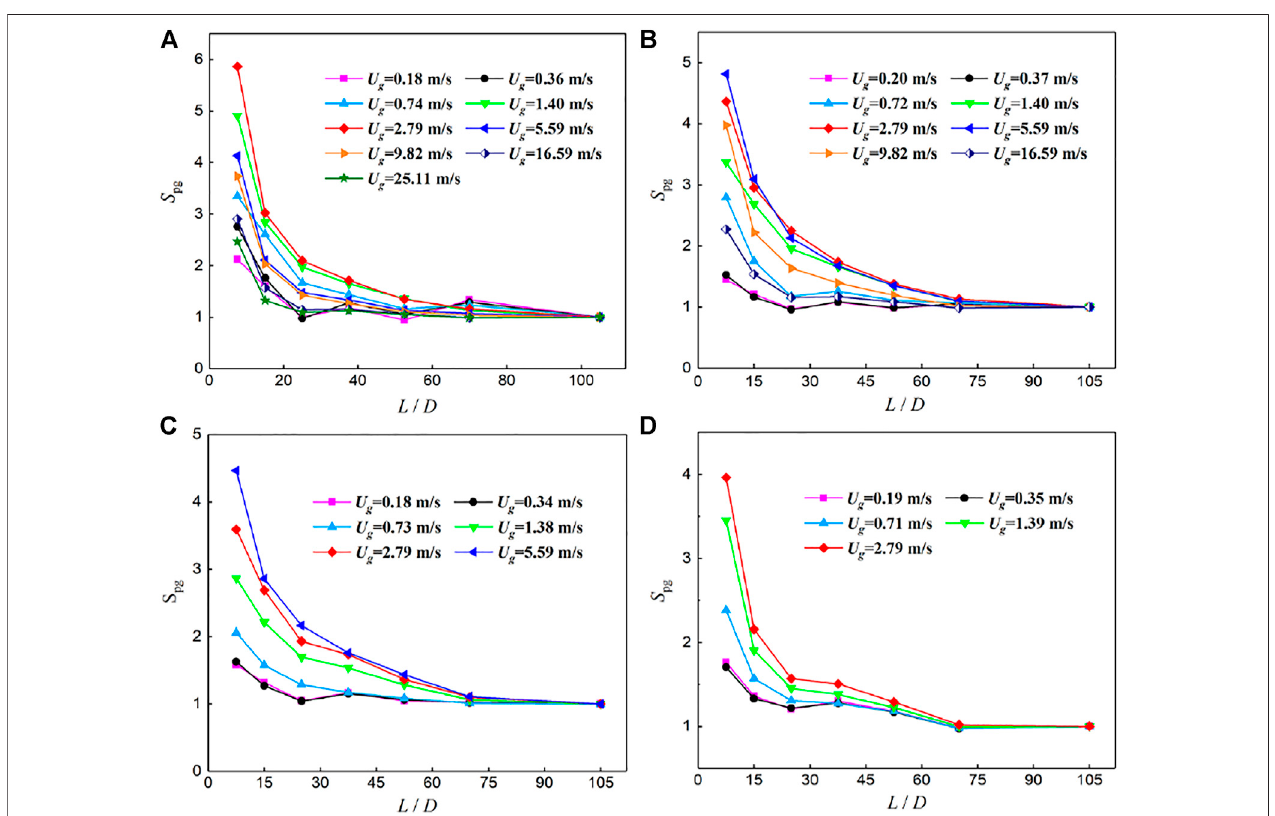
FIGURE 6 | Axial development of S pg for the upstream straight tube of the U-bend ( D = 9 mm and R = 37.5 mm) for the downward fl ow (A) U l = 0.20 m/s; (B) U l = 0.41 m/s; (C) U l = 0.89 m/s; and (D) U l = 1.98